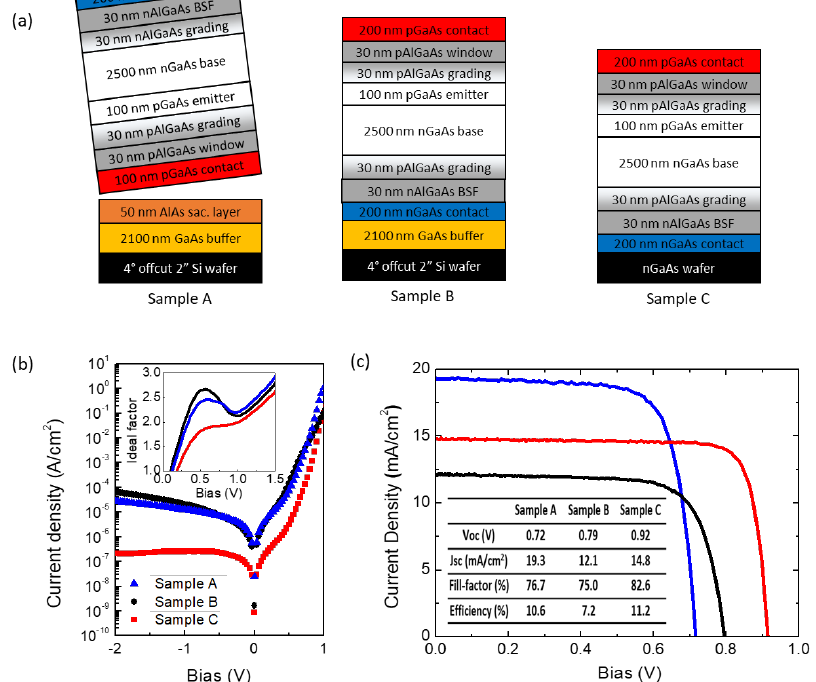
Figure 5. ( a ) Schematic diagrams of the one-junction GaAs solar cells. ( b ) Dark current density (J) − voltage (V) characteristics of GaAs solar cell. Inset shows the ideality factor as a function of bias voltage. ( c ) J − V curves for fabricated GaAs solar cells.